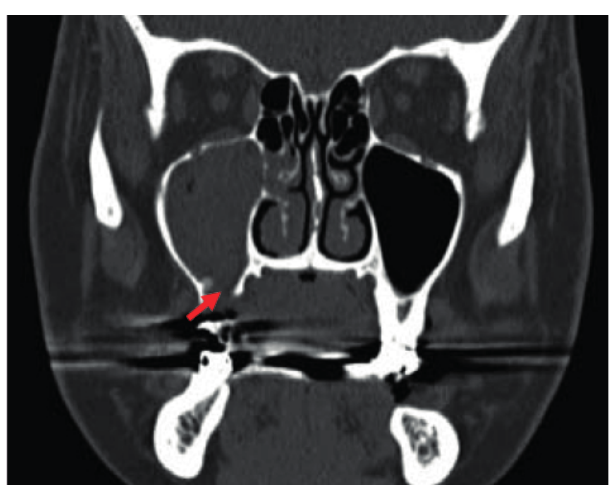
Figure 3. A presurgery CT. The coronal image shows the right maxillary sinus with an oroantral fistula on the inferior wall of the maxillary